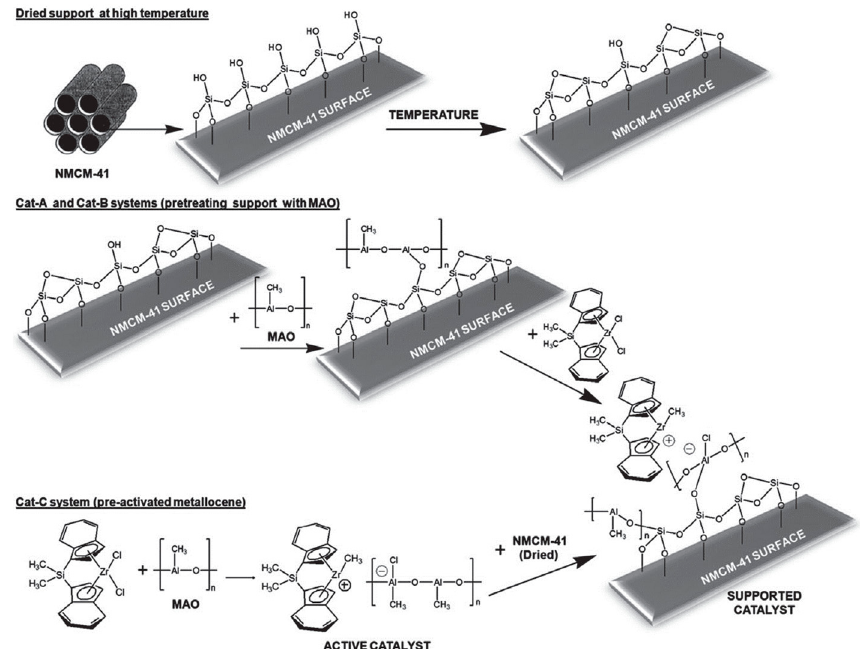
Figure 39. Methodologies of impregnation for Me 2 Si(Ind) 2 ZrCl 2 /NMCM-41. Reproduced with permission from [54]. Copyright 2017 WILEY-VCH Verlag GmbH & Co. KGaA,